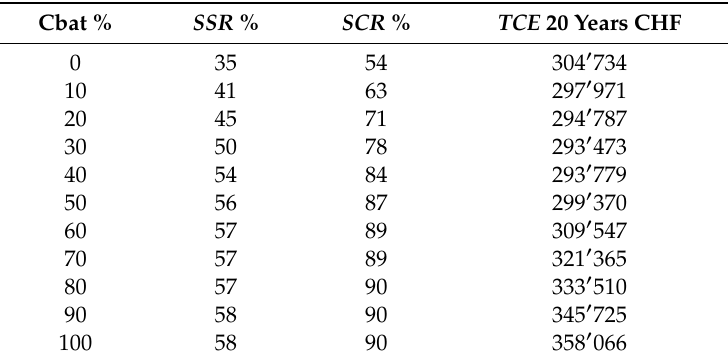
Table 8. Di ff erent factors at di ff erent capacity of the battery for MC1. Table 8. Different factors at different capacity of the battery for MC1.